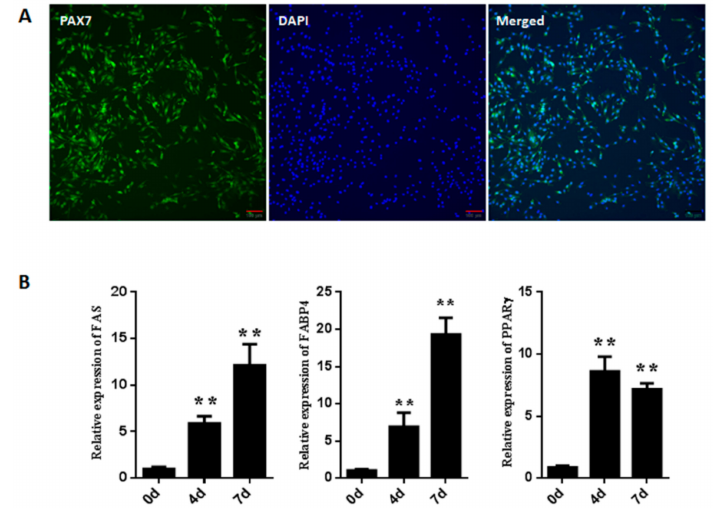
Figure 1. The purity and adipogenic differentiation of goat muscle satellite cells. ( A ) Immunofluorescence analysis of Pax7 in goat muscle satellite cells. Cells were stained with PAX7 antibody and nuclei were stained with DAPI. Scale bars: 100 µ m. ( B ) Relative expressions of adipogenic-regulated genes ( FABP4 , FAS and PPAR γ ) during cell di ff erentiation at 0, 4 and 7 days by qPCR. Error bars represent SEM of three separate experiments. ** p < 0.01 relative to 0 d